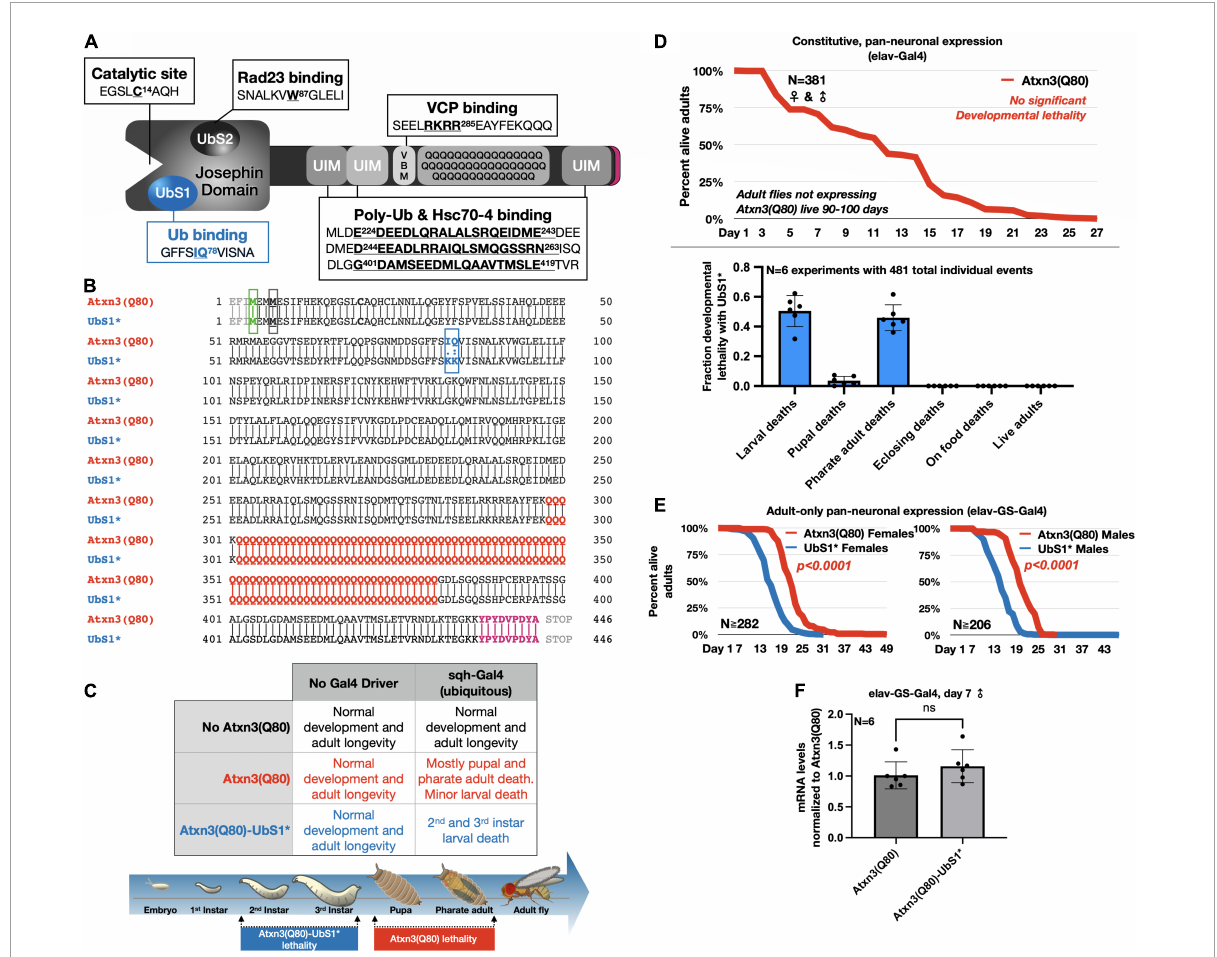
FIGURE1 UbS1 mutation exacerbates Atxn3(Q80) phenotypes. (A) Diagram of Atxn3 domains. This deubiquitinase (DUB) comprises a catalytic domain known as the Josephin domain and a C-terminal portion that consists of various domains. UbS1, ubiquitin-binding site 1; UbS2, ubiquitin-binding site 2; UIM, ubiquitin-interacting motif; VBM, VCP-binding motif. Boxes associated with domains indicate residues important for interactions. (B) Amino acid sequence of Atxn3 proteins used in this study, highlighting first methionine (green); endogenous methionine (black); UbS1 mutation (blue); polyQ tract (red); HA epitope tag (purple). (C) Summary of results from crosses leading to the expression of Atxn3 in all tissues (sqh-Gal4). (D) Summary of results from crosses leading to the expression of Atxn3 in all neurons (elav-Gal4). (E) Summary of results from crosses leading to the expression of Atxn3 in all adult neurons (elav-GS-Gal4). Flies were reared in media without the inducer, RU486, then switched into media with RU486 on the day that they eclosed from their pupal cases. P -values are from log-rank tests. (F) Quantitative-PCR results from expression of Atxn3 versions in adult fly neurons for 7 days. "ns”: not significant, from Wilcoxon